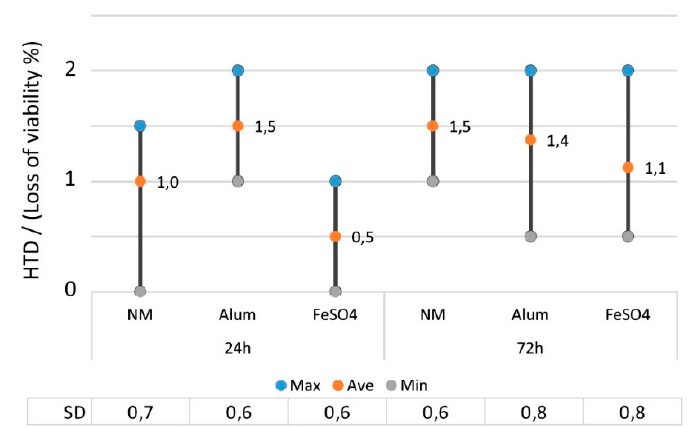
Figure 3. The effect of time on the changes in the morphology and the loss of viability (%) for the mordanted but undyed fabrics, where the HTD value of 1 indicated < 25% loss of viability and 2 between 25–50%. The results contain the values of 1 and 2% EtOH dilutions. NM = no mordant, SD = standard deviation.